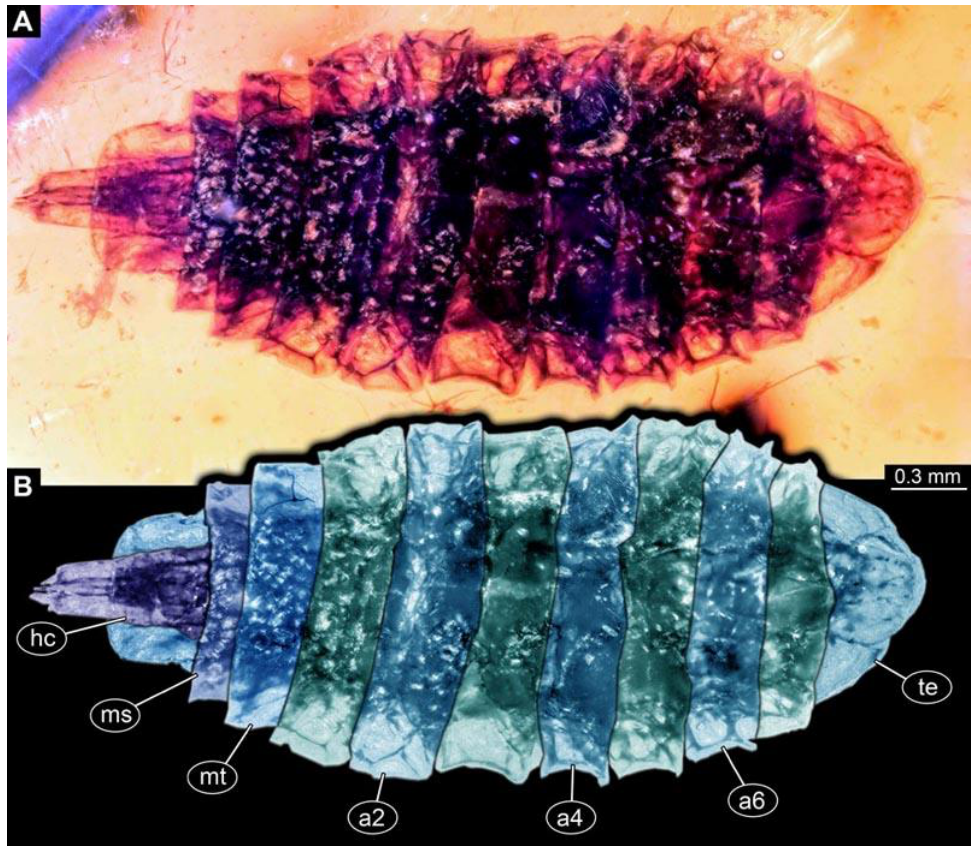
Figure 20. Fossil larva or morphotype 2 or 7, specimen PED 0480. ( A ). Dorsal view. ( B ). Colour- marked. Abbreviations: a2 – a6 = abdomen units 1 – 7; hc = head capsule; ms = mesothorax; mt = metathorax; te = trunk end. (120) PED 0513: Specimen accessible in dorsal and ventral view, better visible in ven- tral view (Figure 21). Bubbles and particles conceal most parts of the dorsal side. Surface structure apparent. Head capsule concealed by bubbles. Ventral spine-like setae well de- veloped. Multiple spine-like setae on trunk end. Dimensions: body length 3.2 mm, body